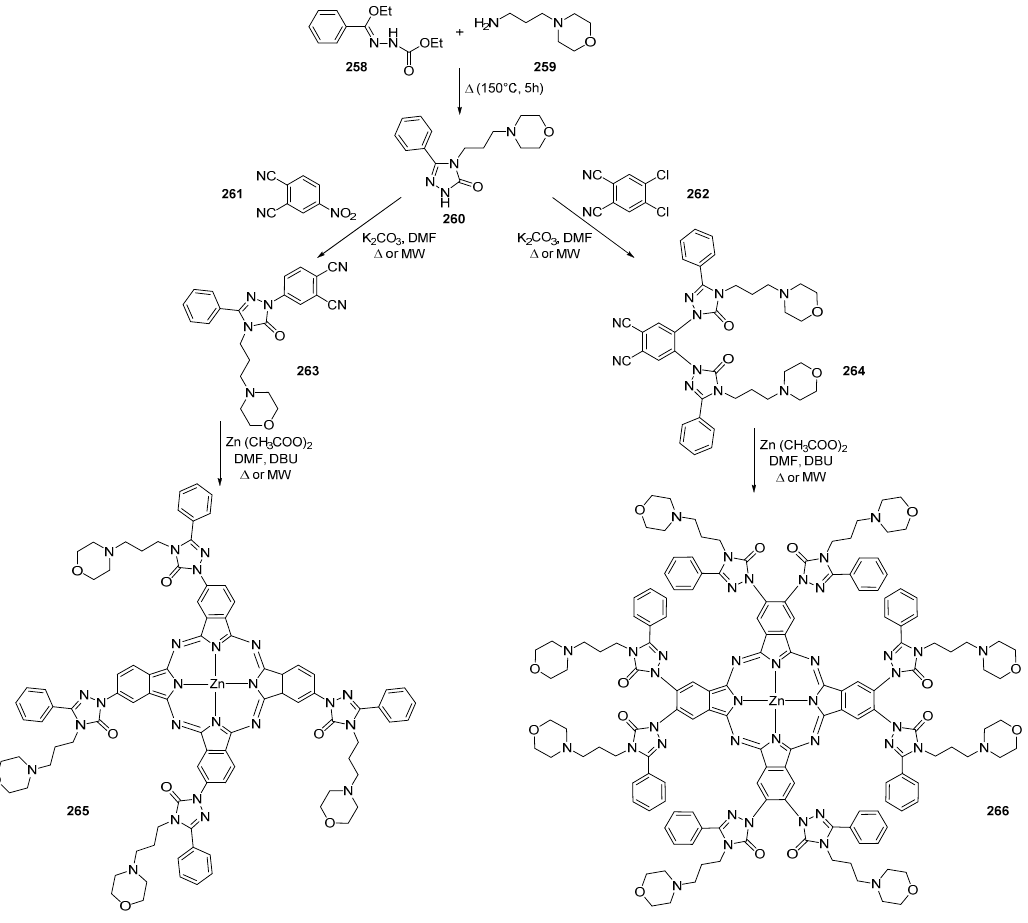
Scheme 56. First example of a MW-activated calix-type